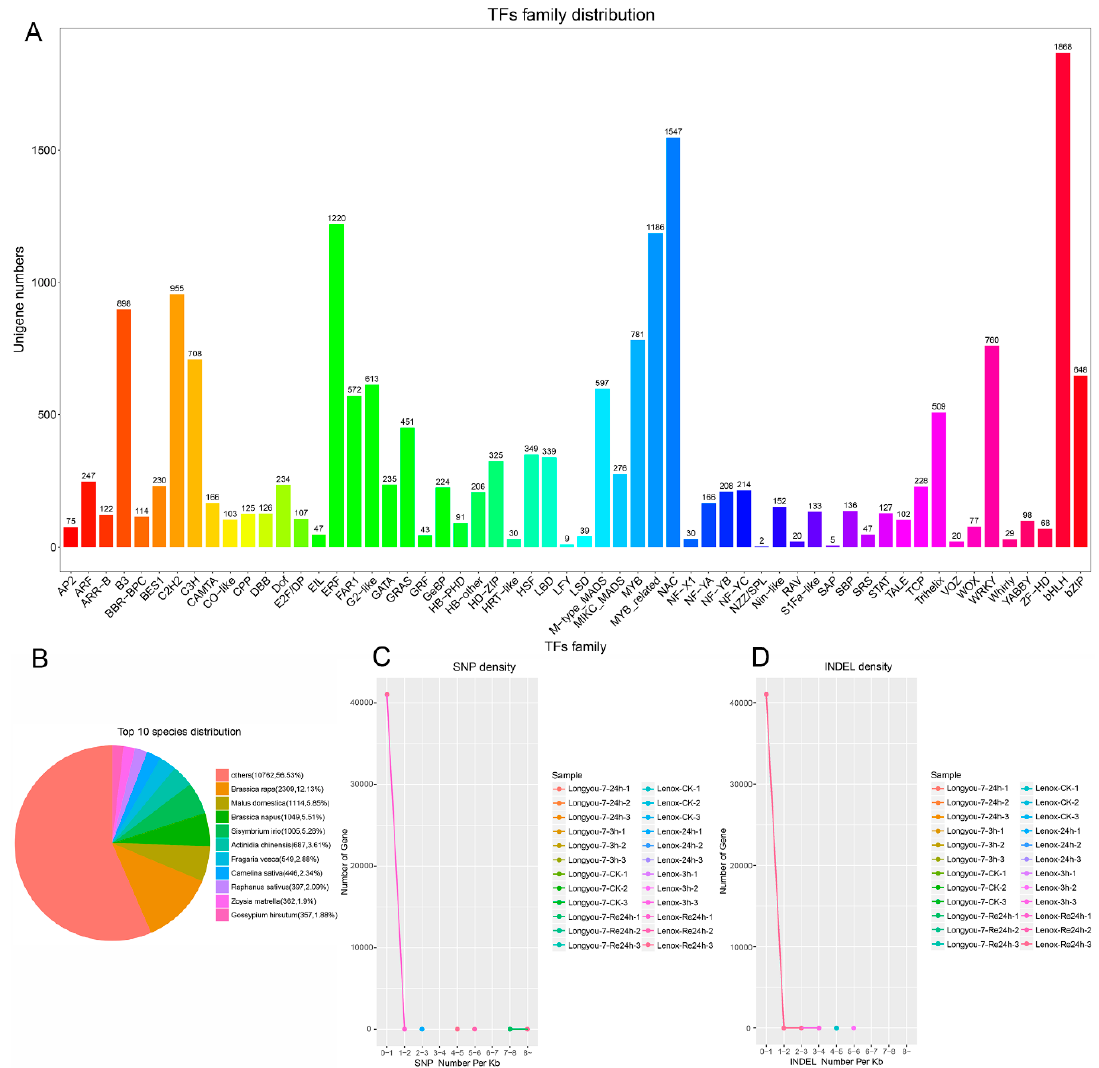
Figure 5. Summary of statistical analysis of transcription factors (TFs), SSRs, and SNPs with cold treatment. ( A ) 58 differentially expressed TFs; ( B ) identified TFs clustered into top 10 species distributions; ( C ) SNP density distribution map; the horizontal axis is the number of SNPs per 1000 bp sequence on the gene and the vertical axis is the number of genes; ( D ) INDEL density map; the horizontal axis is the number of INDELs per 1000 bp sequence on the gene and the vertical axis is the number of genes.